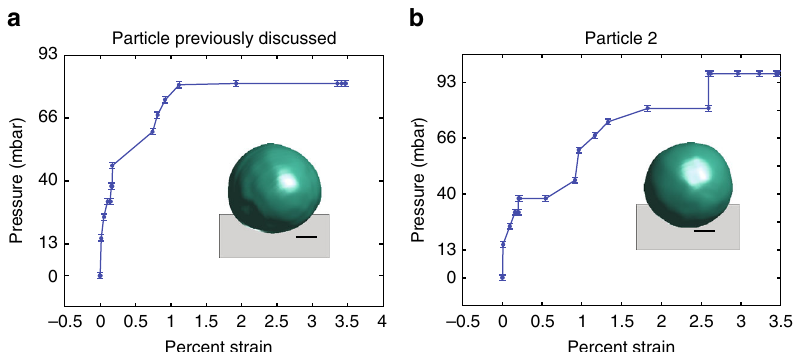
Fig. 3 Example isotherms for particles that undergo defect nucleation. The scale bars represent 100 nm. a The isotherm for the particle previously discussed. Note that the point corresponding to the return to 0 mbar after 81 mbar is omitted for clarity. The isotherm exhibits sloping and more than a single plateau. b The computed isotherm for another particle. Again, the isotherm exhibits sloping and more than a single plateau. Error bars show the average drift in the pressure gauge over the course of the